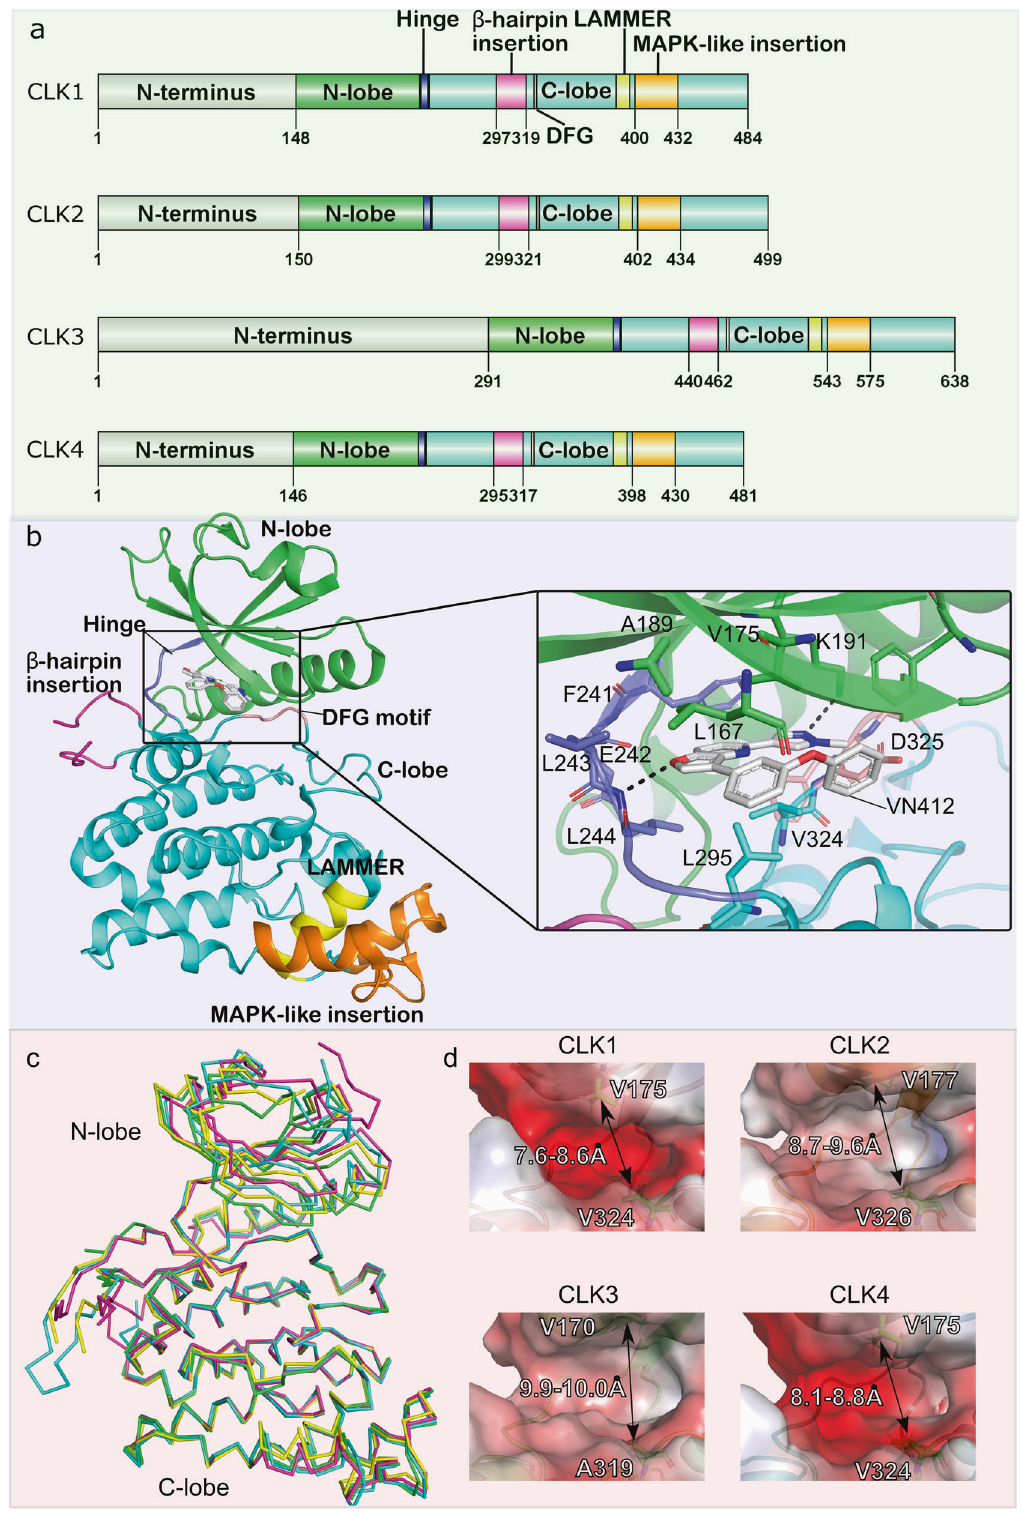
Fig. 1 Structural comparison of human CLKs. a Domain structures of human CLK1, -2, -3, and -4. b Crystal structure of human CLK1 without N-terminus domain (PDB ID: 6I5H). The protein structure backbone is visualized as a cartoon representation, while the ligand and its interacting residues are visualized as sticks. H-bonds are shown as black dashed lines. The coloring of all domains and signature sequence motifs are consistent with panel a . c Structural superposition of CLK1 (PDB ID: 6I5H, green), CLK2 (PDB ID: 6KHE, cyan), CLK3 (PDB ID: 2EU9, magenta) and CLK4 (PDB ID: 6FYV, yellow). The protein structural backbone is represented as a ribbon. d Electrostatic surface representation of CLKs. The blue and red colors represent positive and negative charges, respectively. The different pockets among these kinases were determined by the distances between side chains of conserved Val residue in the N-lobe and DFG-1 residue in the C-lobe